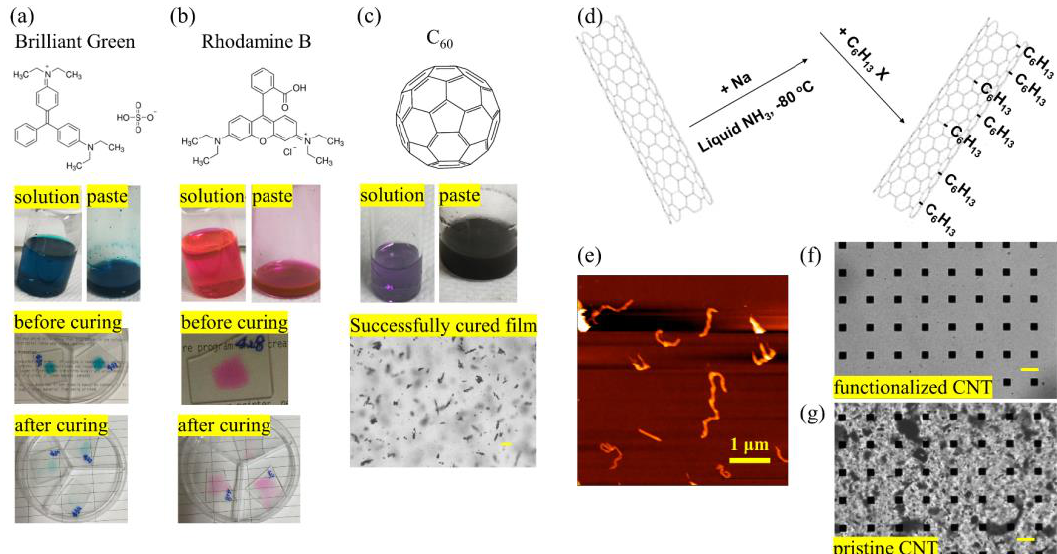
Figure 3. Colored PDMS composites containing various types of light absorbers: ( a ) Brilliant Green, ( b ) Rhodamine B, ( c ) C 60 , ( f ) functionalized CNTs, and ( g ) pristine CNTs. A general protocol with identical synthetic route was adopted, including solvent-assisted dispersion of the filler in the prepolymer, mixing with crosslinker after solvent removal, and thermal assisted crosslinking. The condition of the composite solution, paste, and film in these procedures are imaged and recorded. ( d ) Scheme showing surface grafting reaction of long alkyl chains ( – (CH 2 ) 5 CH 3 ) on a CNT. ( e ) Atomic force microscopy image of functionalized short CNTs. The transmission optical microscope image of the composite pen arrays shows dramatic contrast on the uniformity of the light absorber distribution: ( f ) functionalized CNTs, ( g ) pristine CNTs. The scale bar represents 50 μm, unless specifically noted.